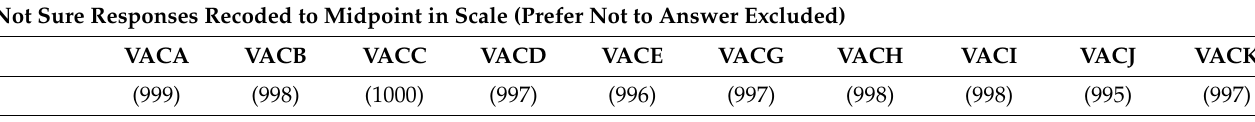
Table 3. Correlations among General Beliefs about Vaccines